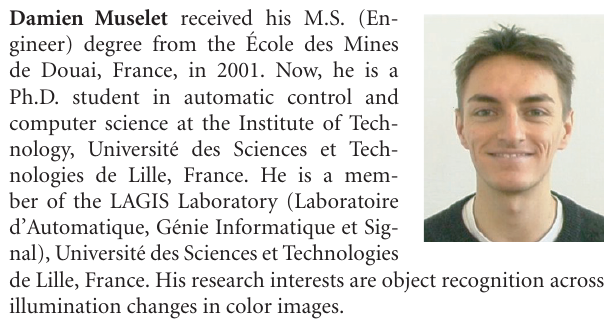
color representation and color image analysis applied to segmenta- tion and